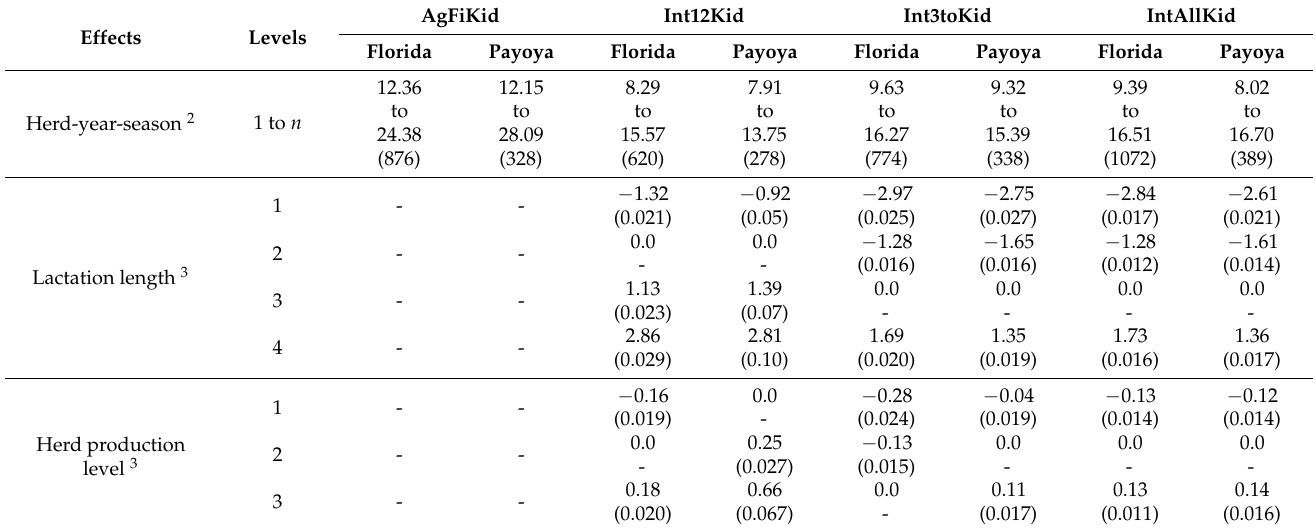
Table 2. Solutions for fixed effects for fertility traits in Florida and Payoya breeds 1